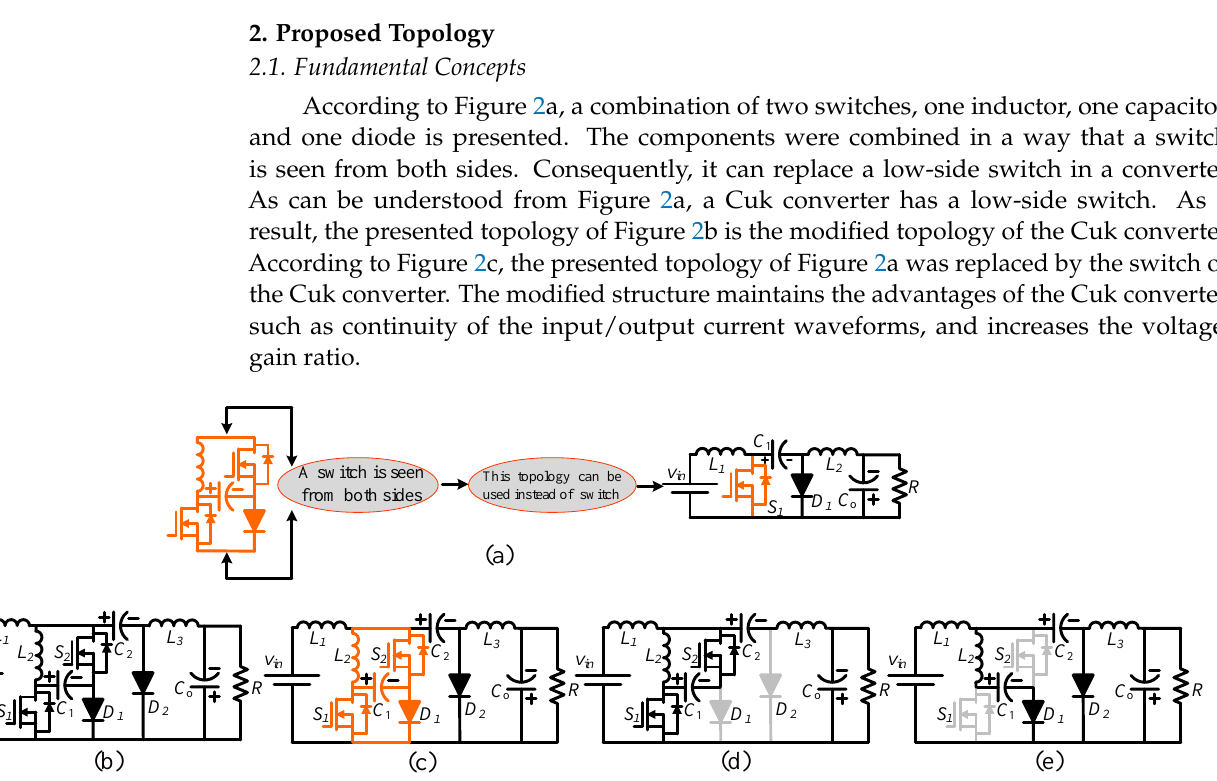
Figure 2. ( a ) Cuk converter and how it was modified; ( b ) the recommended design; ( c ) the procedure of its creation from the recommended structure and Cuk converter; ( d ) the equivalent circuit of the first mode; and ( e ) equivalent circuit of the second